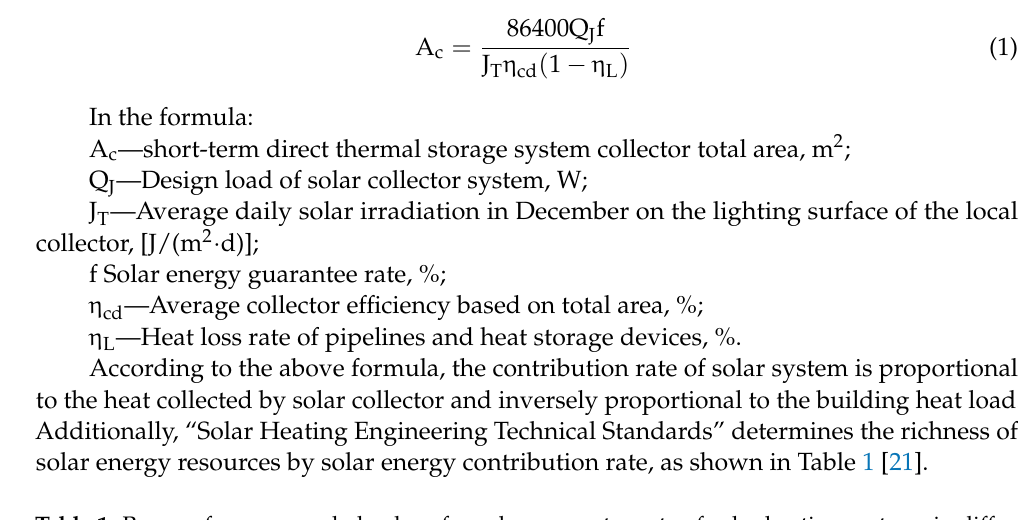
Table 1. Range of recommended values for solar guarantee rate of solar heating systems in differ- ent